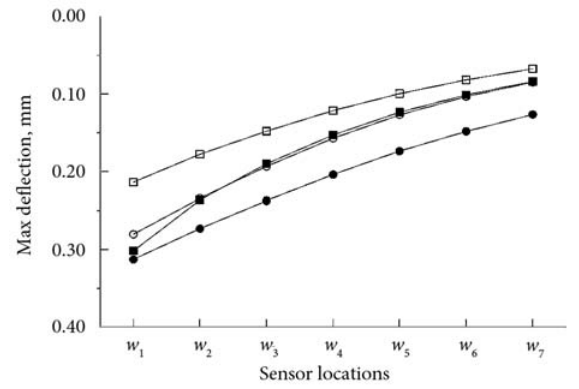
Fig. 2. Comparison of max deflection curves for